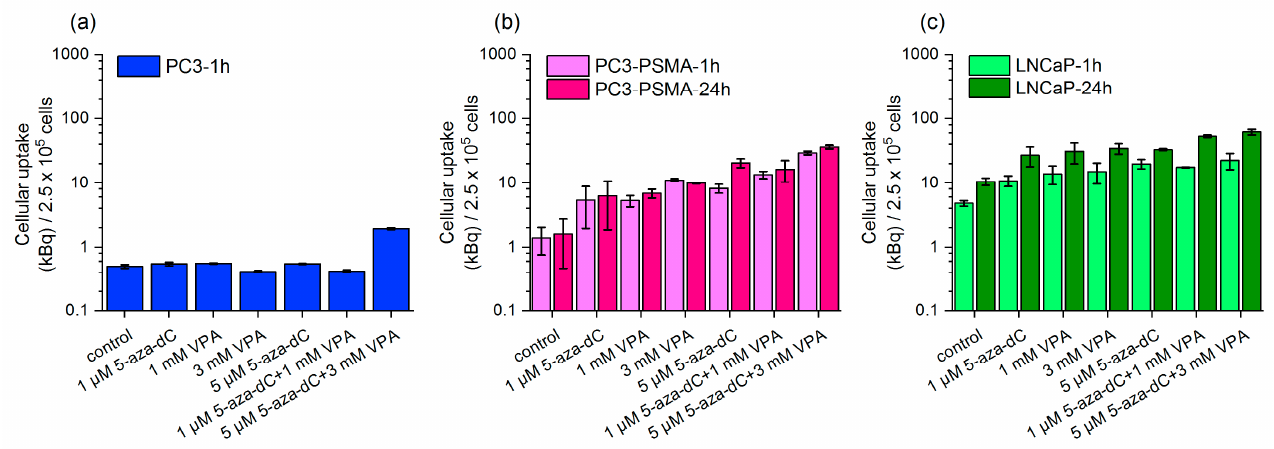
Figure 2. Total cell-bound Lu-177–PSMA-617 (50 kBq/mL radioactive solution) ( a ) for 1 h in PC3 cells, for 1 h and 24 h in ( b ) PC3-PSMA, and ( c ) LNCaP cells after stimulation by 5-aza-dC and VPA. Unstimulated cells (control) were simultaneously incubated with Lu-177–PSMA-617. Data show the average ± SEM.